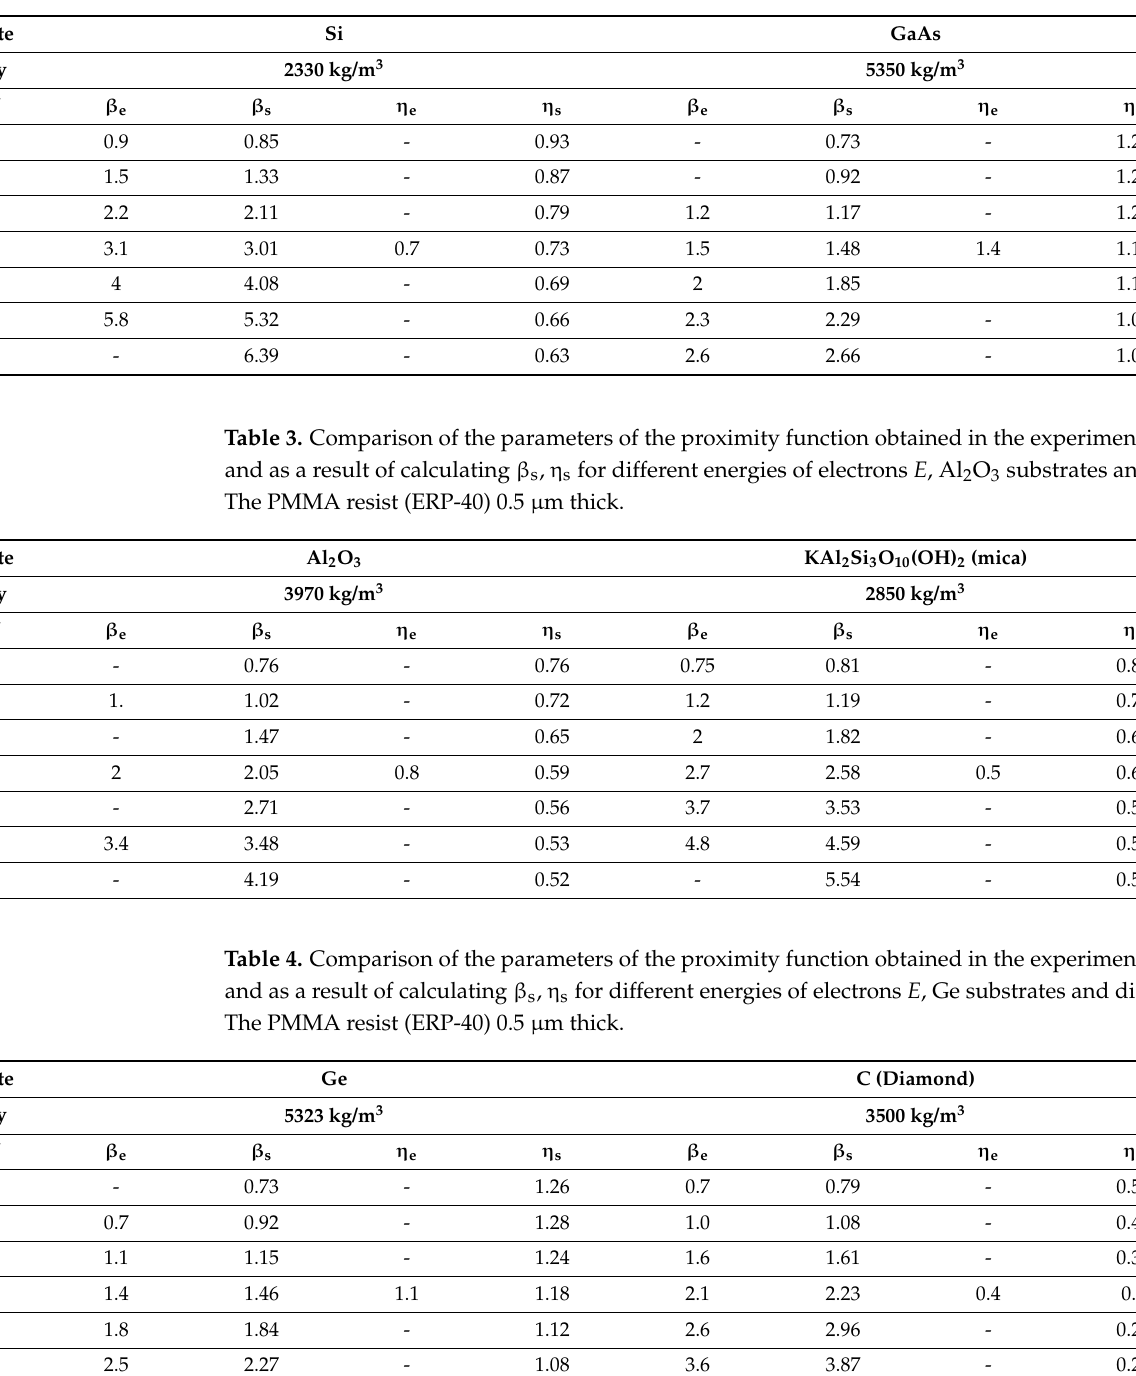
Table 2. Comparison of the parameters of the proximity function obtained in the experiment β e , η e and as a result of calculating β s , η s for different energies of electrons E and Si and GaAs substrates. The PMMA resist (ERP-40) 0.5 µ m thick.